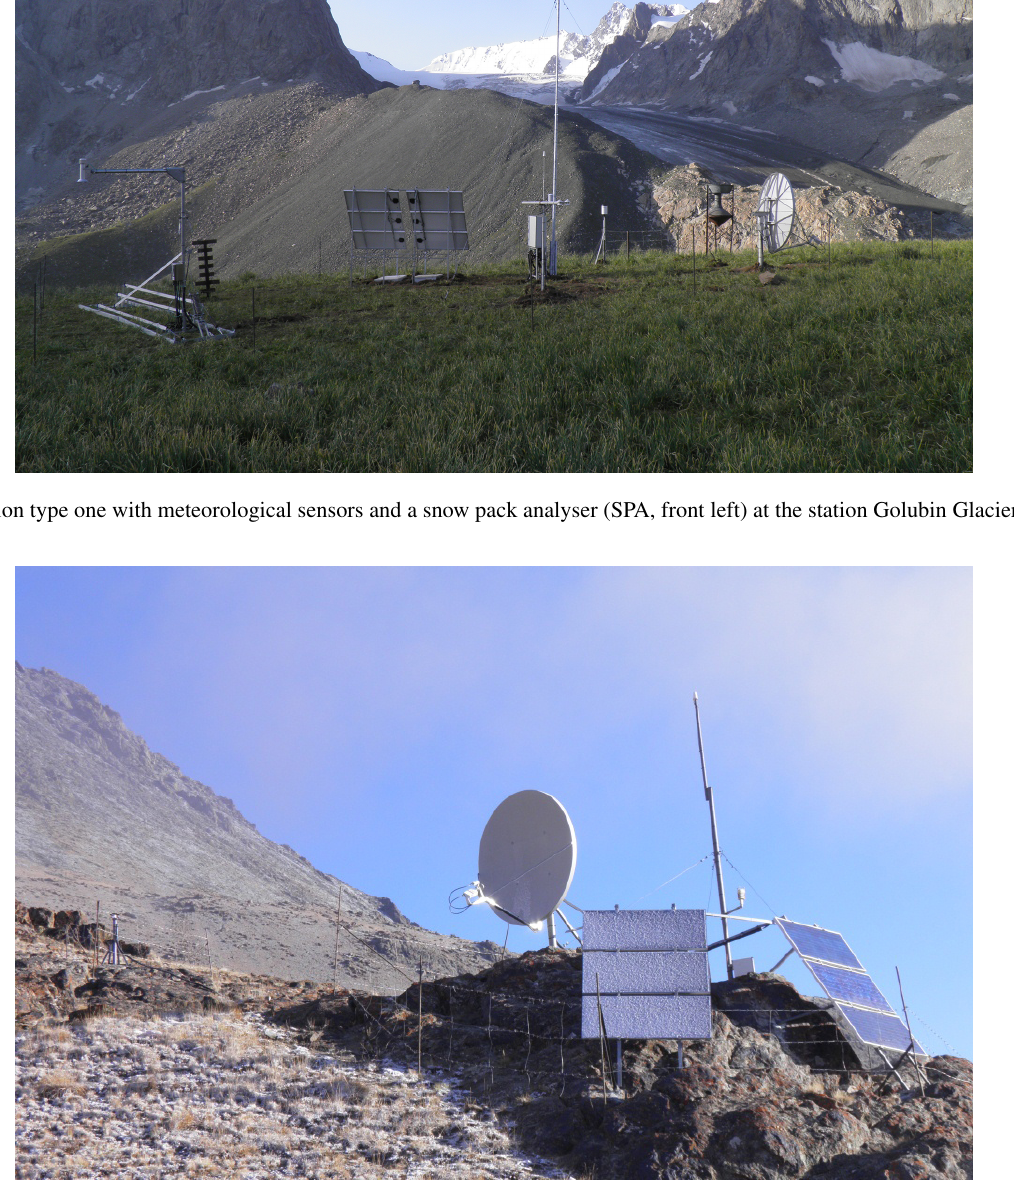
Earth Syst. Sci. Data, 13, 1289–1306, 2021